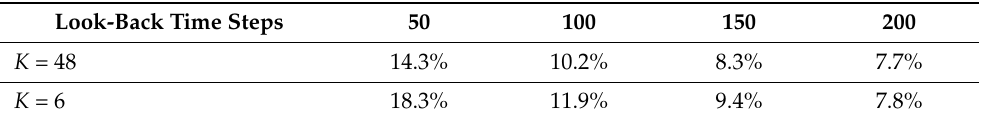
Table 7. MAPE of load forecasting results for different look-back time steps in the LSTM network. Look-Back Time